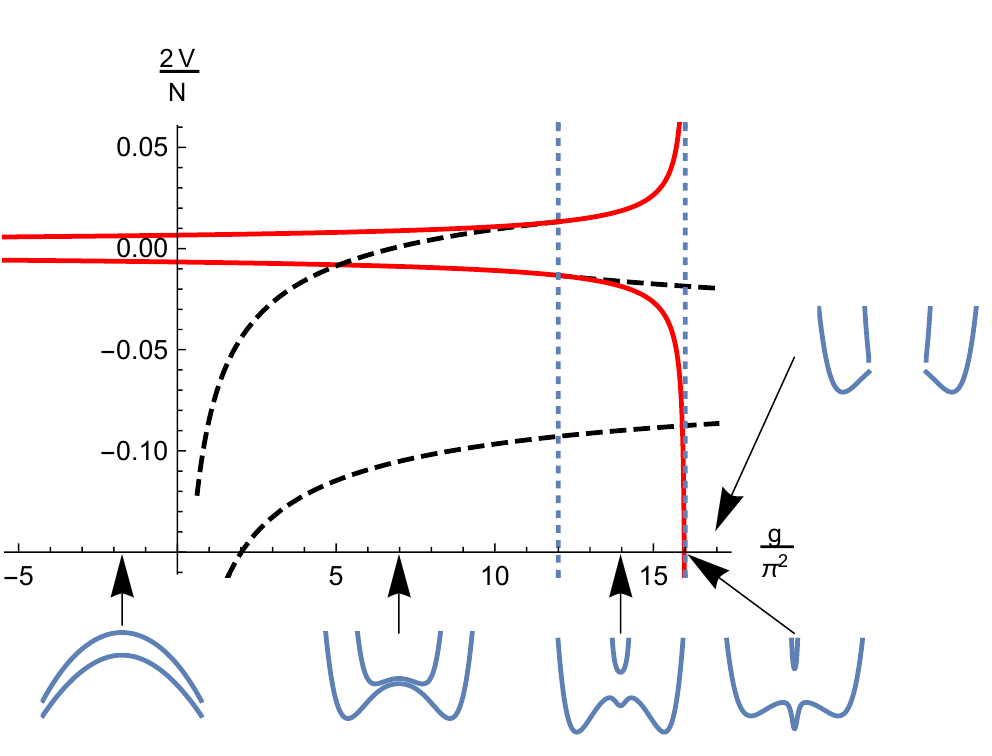
Figure 3 . Potential vs. coupling. The solid curves are disordered ( (cid:30) (cid:11) = 0) and the dashed curves are boundary ordered ( (cid:30) (cid:11) 6 = 0). The disordered phases cease to exist for g > 16 (cid:25) 2 while the ordered phases require g > 0. The disordered phases can join with the ordered phases at g = 12 (cid:25) 2 . Dotted vertical lines are placed at g = 12 (cid:25) 2 and g = 16 (cid:25) 2 as a guide to the eye. The inset plots show the qualitative shape of the potential as a function of (cid:8) in the di(cid:11)erent regions of the larger plot. There are two di(cid:11)erent branches of V ((cid:8)): the upper branch corresponds to (cid:22) < 0 and the lower branch to (cid:22) >